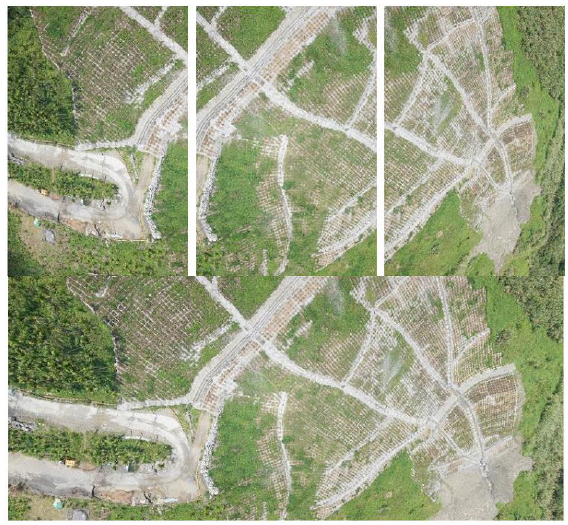
Figure 3. Sample of three-camera raw images and the stitched result.